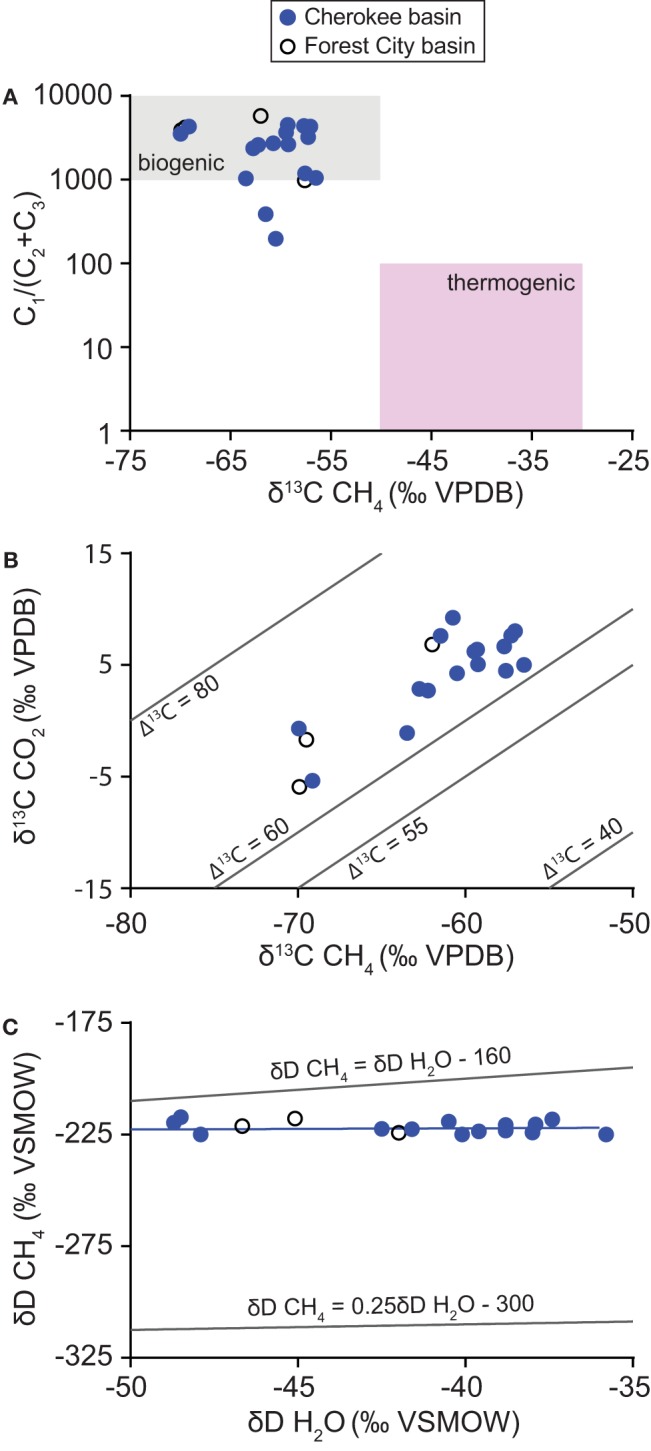
Variation in (A) gas dryness index values [C1/(C2+ C3)] relative to the carbon isotope ratio of methane, (B) carbon isotope ratios of carbon dioxide relative to methane, and (C) hydrogen isotope ratios of methane relative to water. Data were collected from coalbed methane wells in the Cherokee basin (this study) and the Forest City basin (McIntosh et al., 2008). Δ13C-values in (B) are calculated as difference in carbon isotope ratios of carbon dioxide and methane (Δ13C = δ13C CO2− δ13C CH4). Graph (C) includes a best-fit line through Cherokee basin data (δD CH4 = 0.05δD H2O − 220) and lines defined by Whiticar (1999) for hydrogenotrophic and methylotrophic methanogenesis (Equations 1 and 2, respectively).